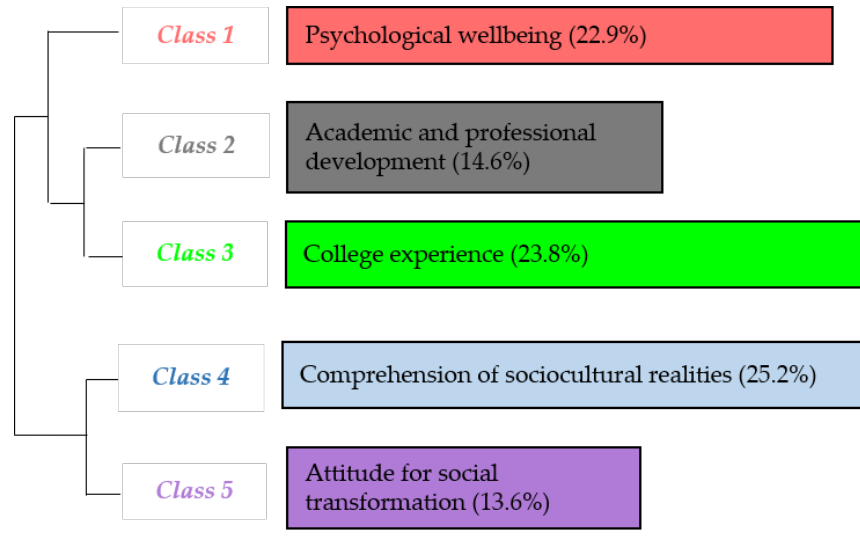
Figure 5. Dendrogram of the postinterview classes.